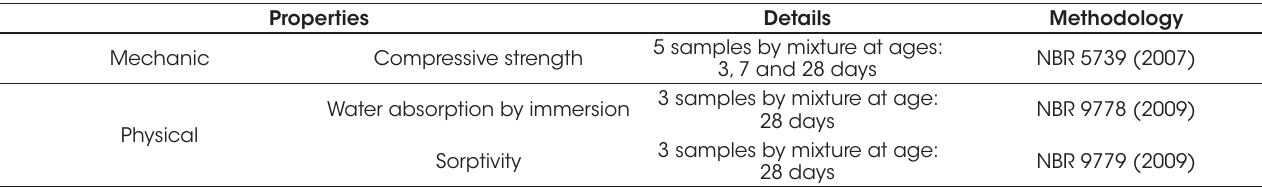
Methodology of the essays conducted Properties